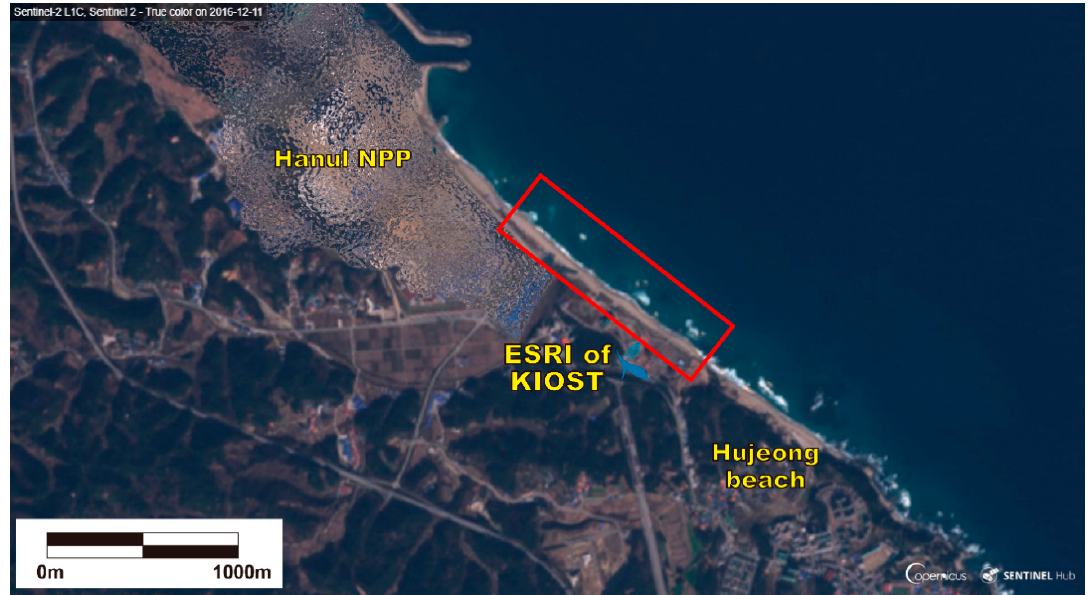
Figure 3. Image on Hujeong Beach measured by Sentinel-II on December 11, 2016, downloaded from Creodias platform (creodias.eu). The red rectangle marks the coverage of the VMS shown in Figure 2.